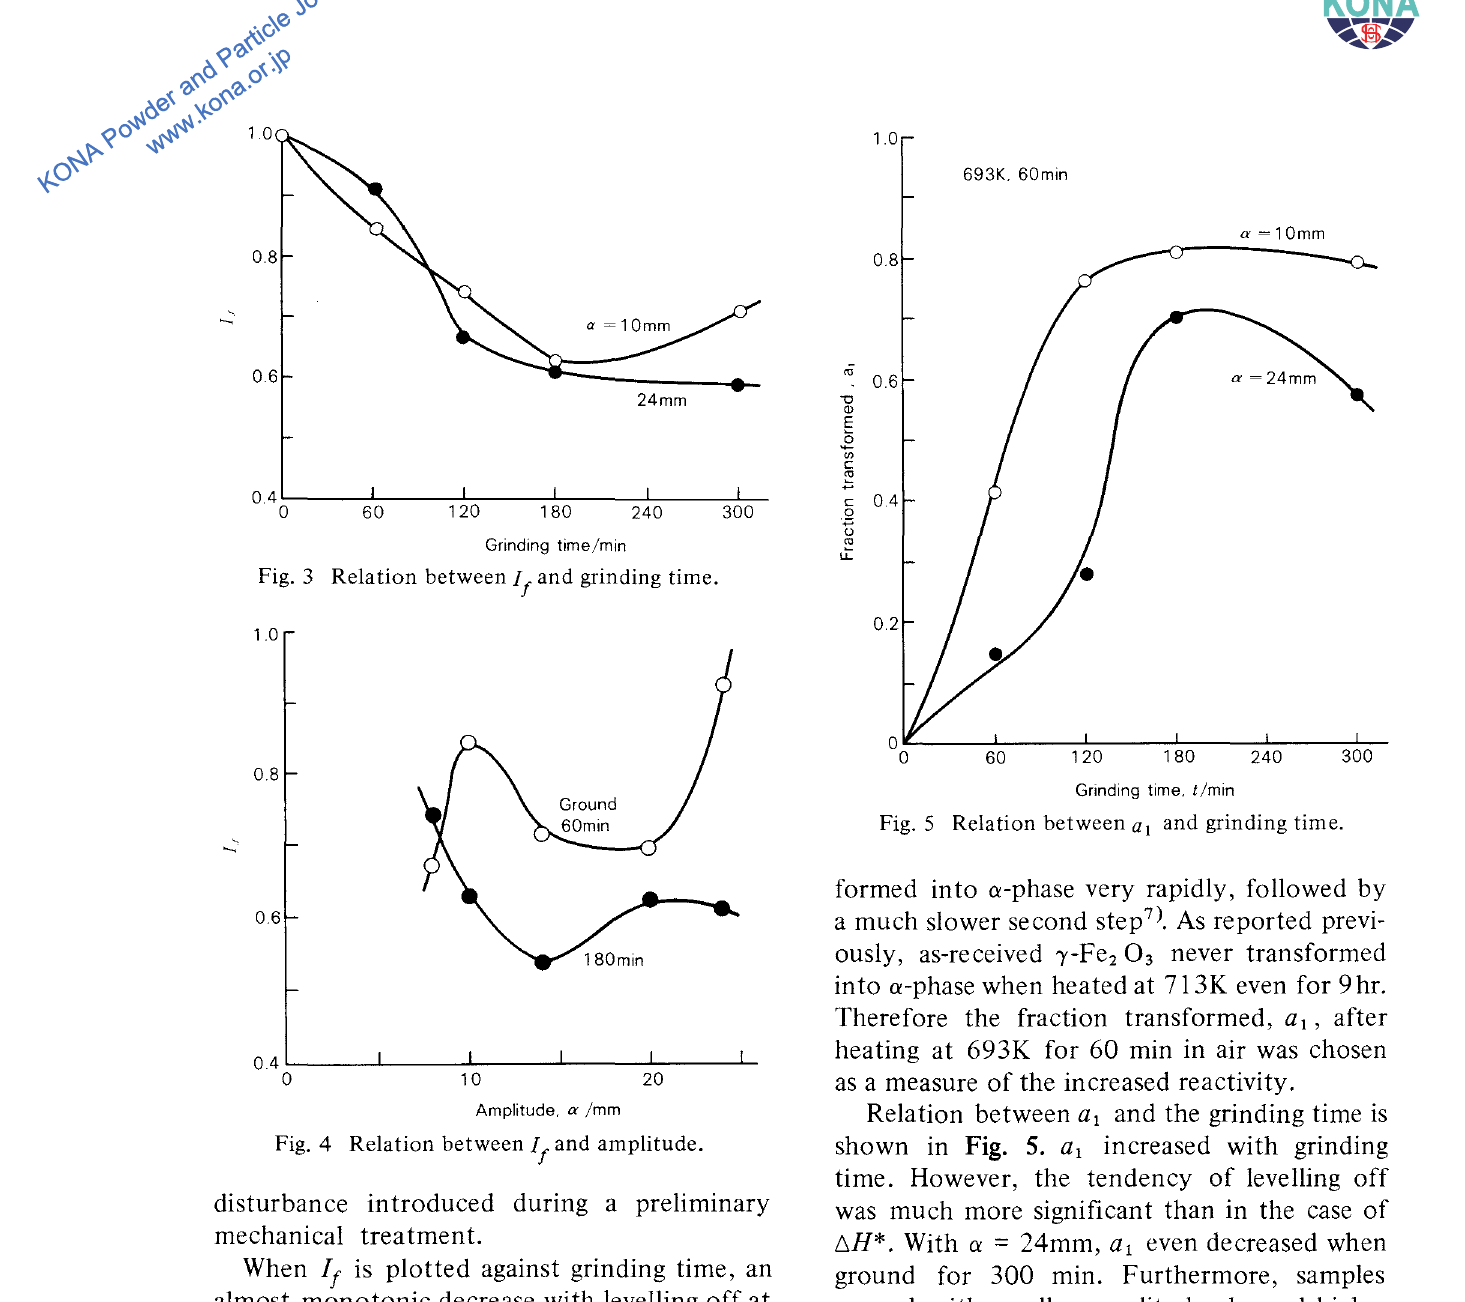
Fig. 4 Relation between If and amplitude.